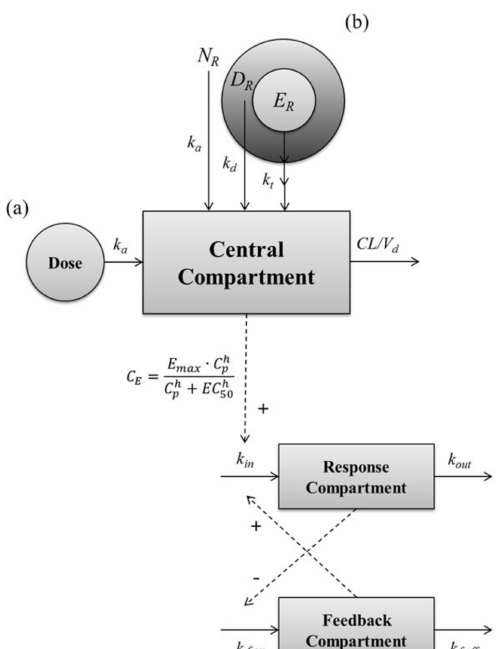
Figure 5. A schematic representation of the entire PK–PD model of leuprolide on the plasma testosterone level after SC administration of (a) leuprolide solution and (b) SR depot. Solid lines with arrows indicate the elimination or distribution of PKs, or indicate the production or elimination of responses. Dashed lines with arrows indicate the stimulatory or inhibitory effect of PDs. N R , the ratio of entrapped leuprolide in the non-capsuled section; D R , the ratio of entrapped leuprolide in the